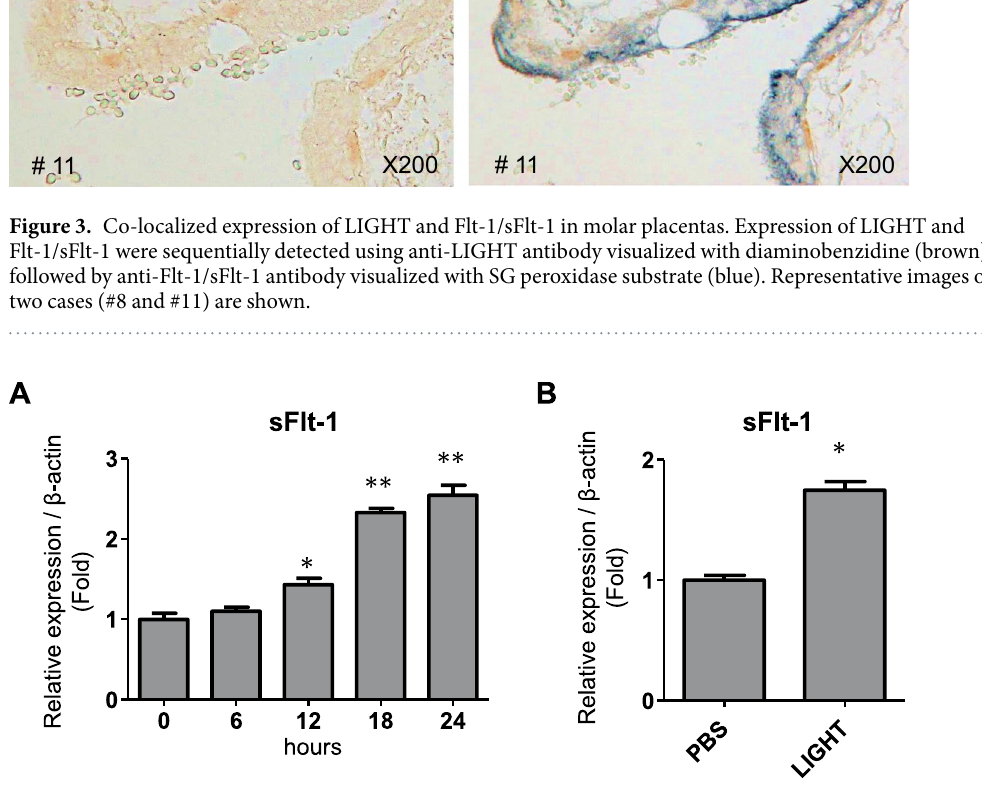
Figure 4. LIGHT induces sFlt-1 expression in human trophoblast cells. ( A ) HTR-8/SVneo cells were treated with 100 pg/ml recombinant human LIGHT under ambient oxygen levels. mRNA was extracted from cells, and sFlt-1 mRNA levels were determined by real time RT-PCR (n = 4 each). * P < 0.05, ** P < 0.01 vs base line (0 hour). ( B ) Cultured syncytiotrophoblast cells were treated with 100 pg/ml LIGHT for 18 hours under ambient oxygen levels. mRNA was extracted from cells, and sFlt-1 mRNA levels were determined by real time RT-PCR (n = 3 each). * P < 0.05 vs